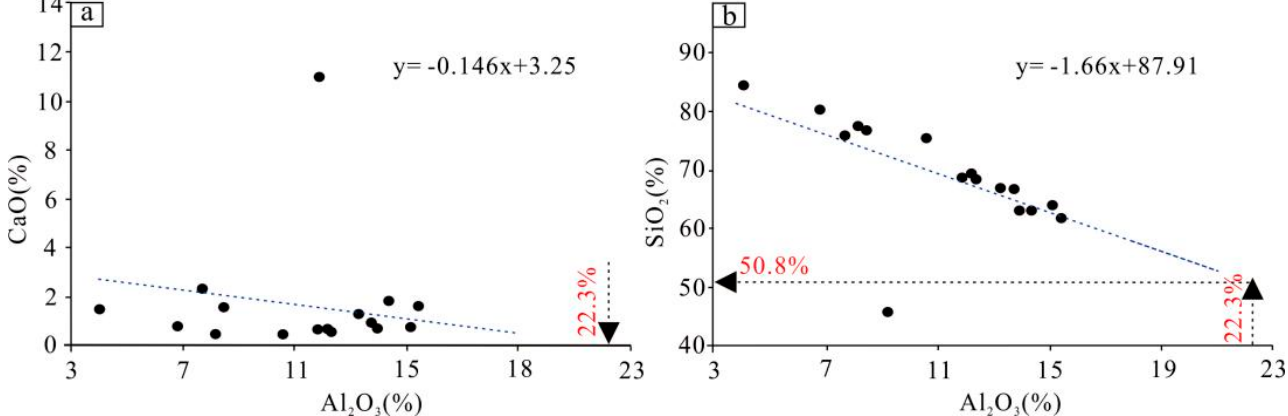
Figure 2. Correlations between CaO vs Al 2 O 3 ( a ), and SiO 2 vs Al 2 O 3 ( b ) from well ZY5. One outlier with high carbonate content (CaO = 11.1%) was not viewed as representative.